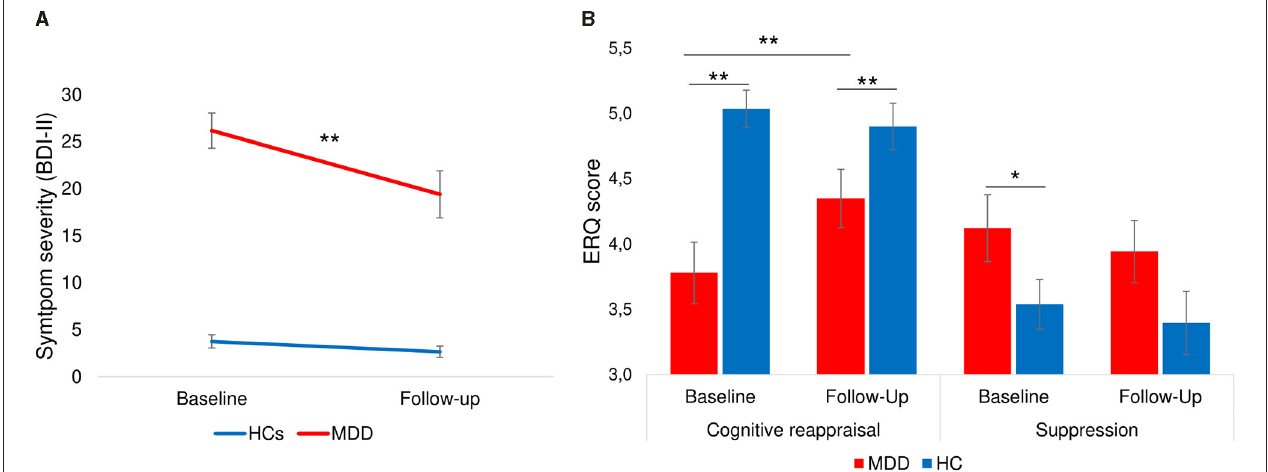
FIGURE 5 | Change of severity of depression and emotion regulation ability from baseline to follow-up. (A) Symptom severity measured by BDI-II showing a significant decrease of symptom scores from baseline to follow-up only in patients with depression [9.2 ± 11.8; t (28) = 4.2, p < 0.001]. (B) Patients showed a significant increase of cognitive reappraisal and a stable level of suppression strategies. Healthy individuals had stable levels of cognitive reappraisal and suppression. Error bars indicate standard errors. ** p < 0.001, * p <